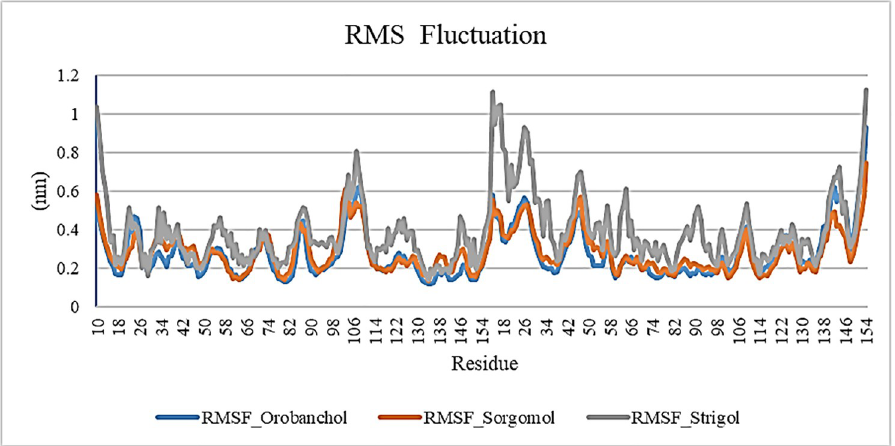
Fig 5. Root mean square fluctuation (RMSF) of c-alpha for the protein in interaction with Sorgomol, Orobanchol and Strigol during 100 ns simulation.